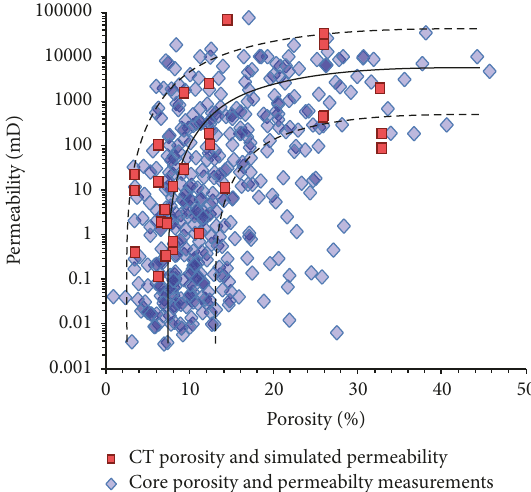
Figure 11: Porosity-permeability cross-plot for laboratory core measurements and LBM simulations. The black line is the best fit curve to the data and the dashed lines delineate the zone defined by 90% of the data points closest to the best fit